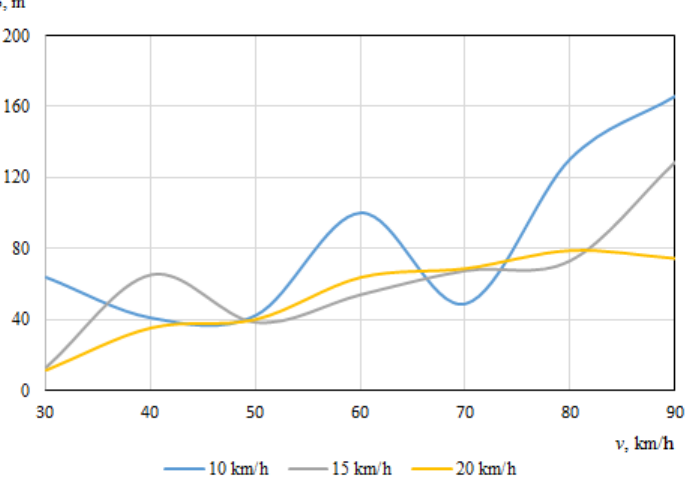
Figure 18. Throwing distances of the bicycle (impact angle 90°).